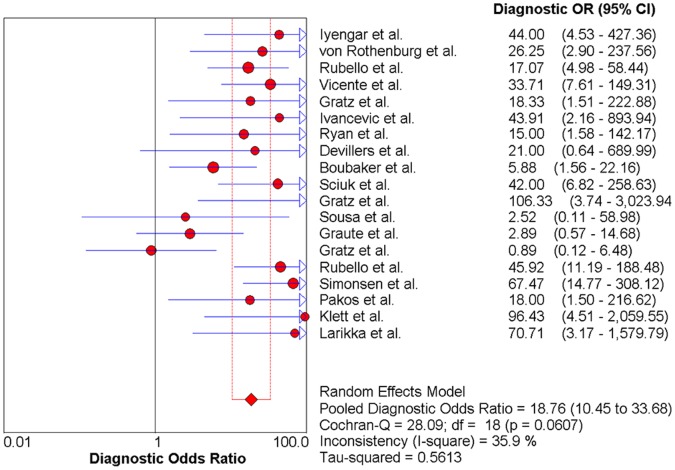
Forest plot for the diagnostic odds ratio (DOR) of anti-granulocyte scintigraphy with 99mTc-monoclonal antibodies to diagnose periprosthetic joint infections (PJI).DOR (diagnostic odds ratio)  =  18.76 (95% CI, 10.45-33.68).